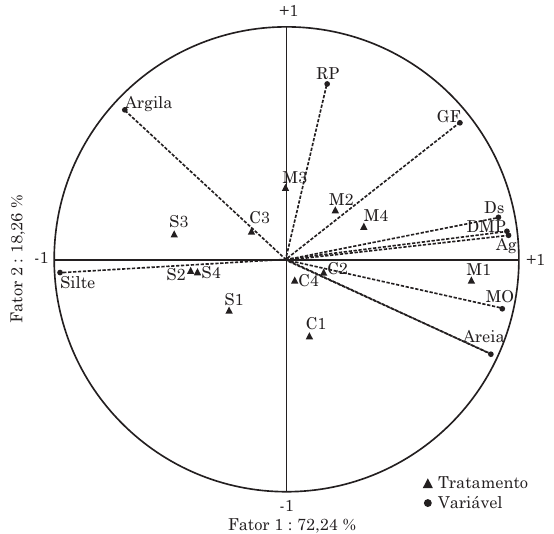
Figura 5. Dispersão dos atributos físicos em diferentes condições de uso do solo. Ag: porcentagem de agregados estáveis na classe (> 2,0 mm); DMP: diâmetro médio ponderado; Ds: densidade do solo; GF: grau de floculação; MO: matéria orgânica; RP: resistência à penetração. C1, C2, C3 e C4 correspondem ao sistema de cultivo de mamoeiro sob camalhão; S1, S2, S3 e S4, ao sistema de cultivo de mamoeiro sob sulco; e M1, M2, M3 e M4, à mata nativa secundária, todos, respectivamente, às